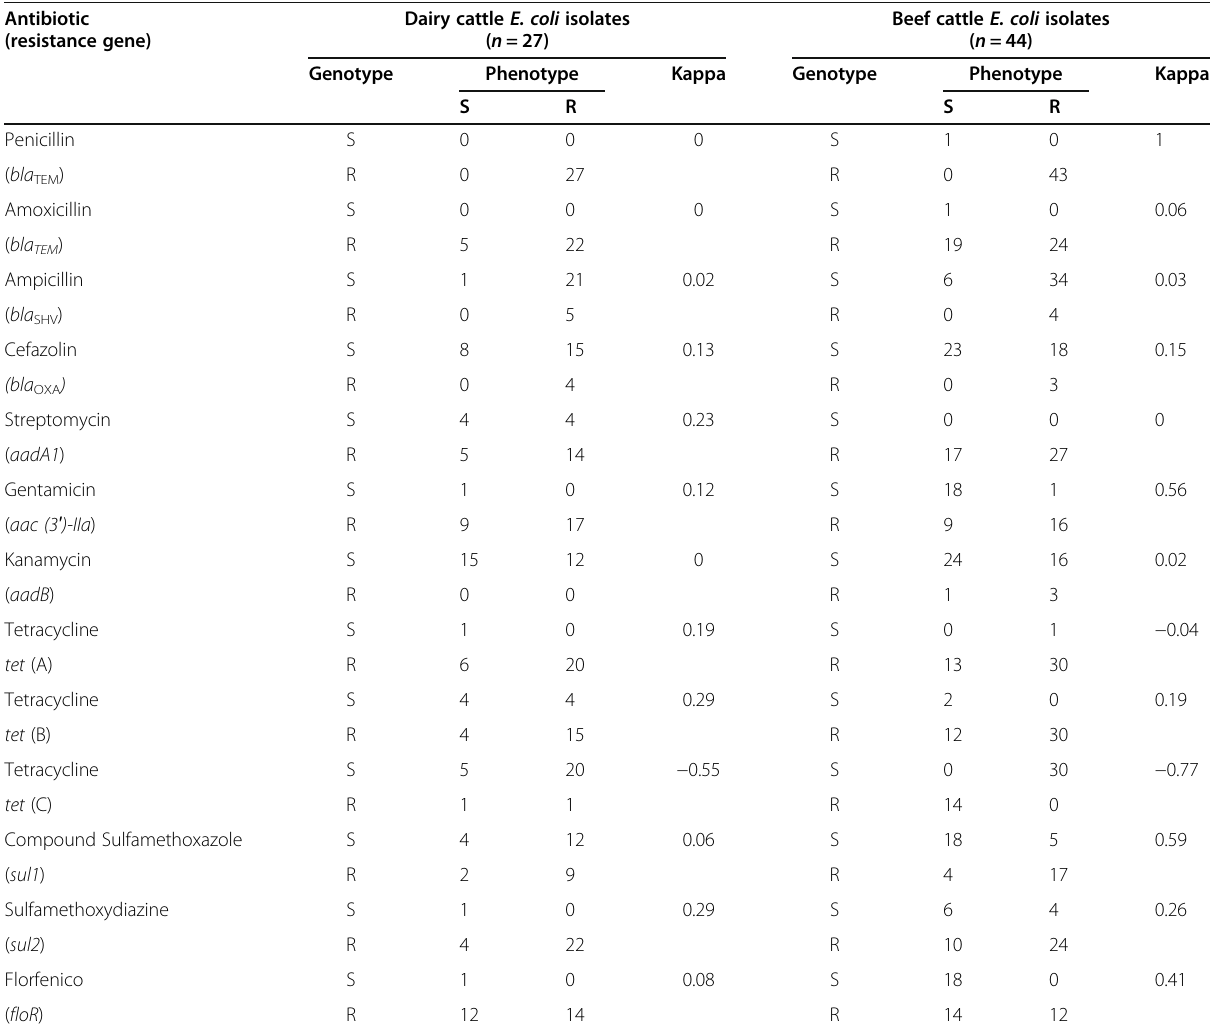
Table 3 Analysis of correlation between antibiotic resistance phenotype and genotype Antibiotic (resistance